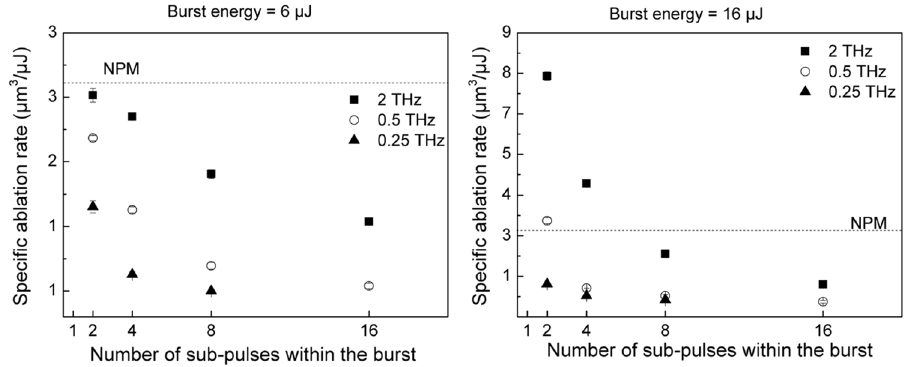
Figure 6. Specific ablation rate versus the number of pulses within the burst, at a burst energy of 6 µJ (left) and 16 µJ (right). The specific ablation rate obtained in NPM is shown by the dashed